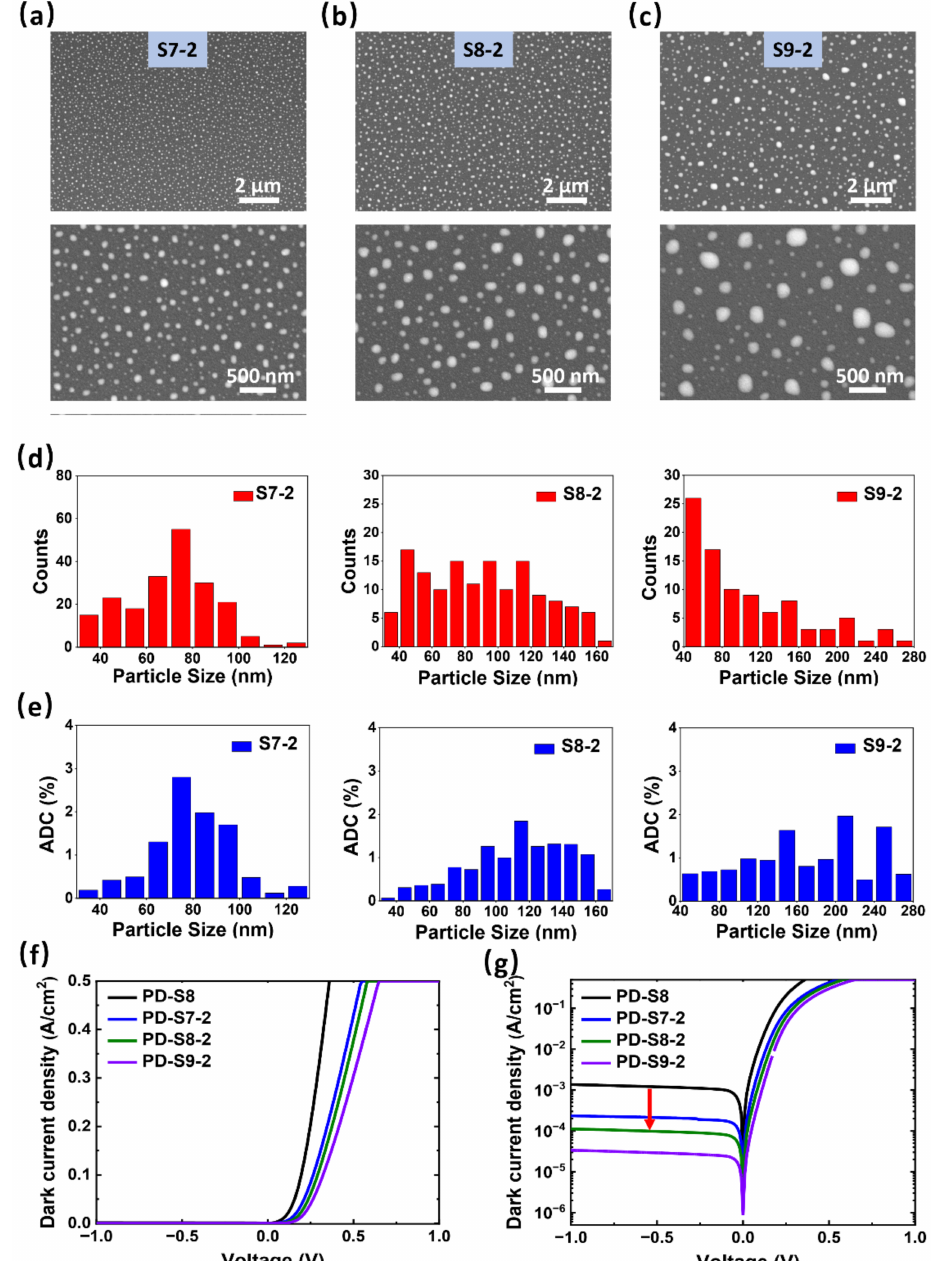
Figure 3. SEM images of Au NPs’ distribution with 2 nm Au layers capped on. The thicknesses of the Au layer to be annealed at 450 ◦ C for 10 min were ( a ) 3.5, ( b ) 5, and ( c ) 6.5 nm, respectively. Histograms of NPs’ characteristics exported from the figure ( a ): ( d ) size and ( e ) area duty cycle (ADC). The dark current densities of PDs with different Au NPs at − 1 to 1 V in ( f ) linear scale and ( g ) semi-log